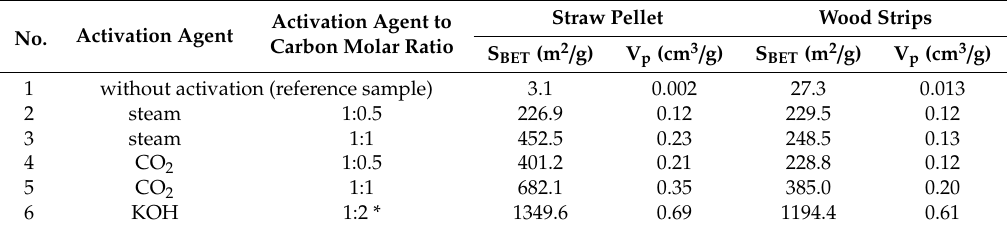
Table 2. Surface area (S BET ) and pore size (V p ) of the activated carbon obtained from the straw pellet and waste wood. Activation